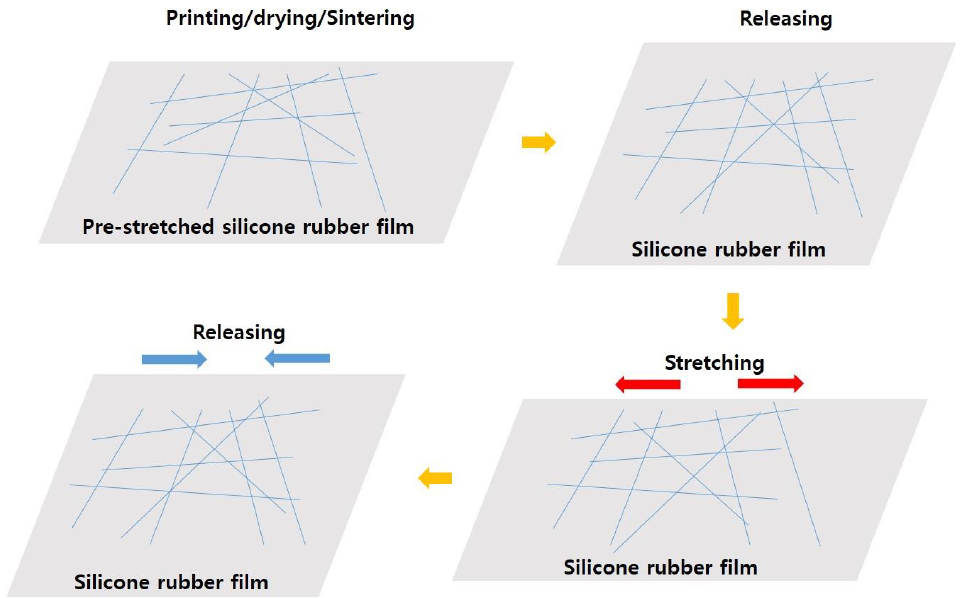
Figure 8. The schematics of Ag NWs sliding applying strain on pre-stretched film.